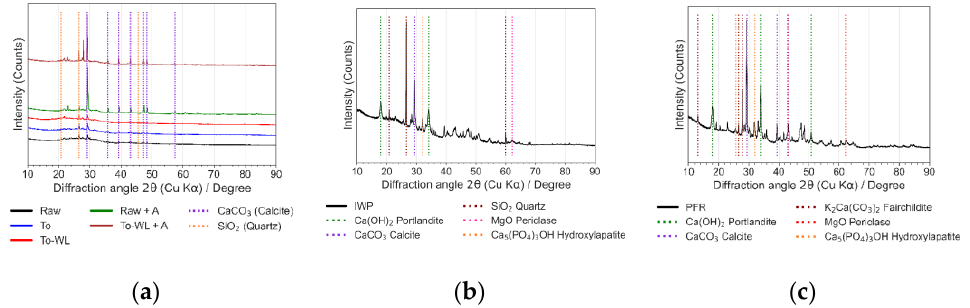
Figure 8. XRD spectra of the sample material (ashes): pre-treated and/or CaCO 3 -blended wheat straw ( a ), industrial wood pellets ( b ), and pine forest residues ( c ).